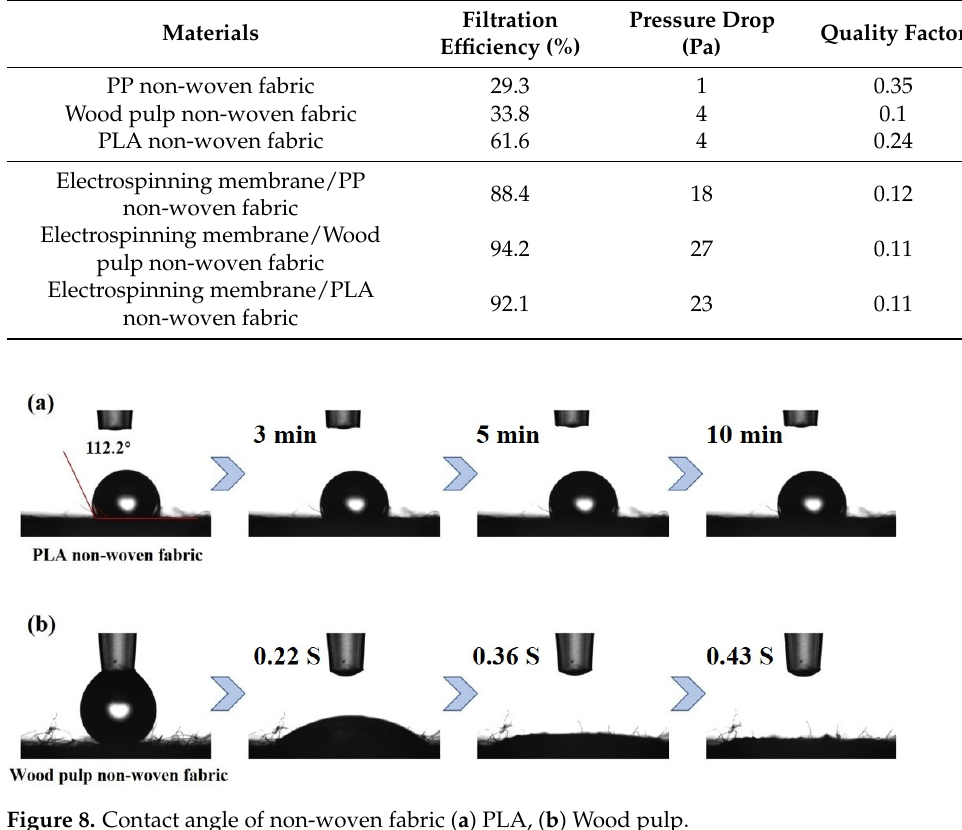
Figure 8. Contact angle of non ‐ woven fabric ( a ) PLA, ( b ) Wood